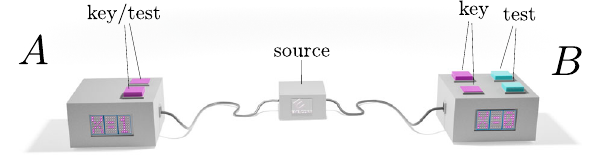
Fig. 1 Robust DIQKD. Alice and Bob use uncharacterised devices to perform measurements on a quantum state that is created by a source that is potentially controlled by an adversary (Eve). In the proposed protocol, Alice has two possible inputs (measurement settings, magenta buttons) which are used for key generation and for running the CHSH Bell test, and Bob has four possible inputs grouped into two sets (magenta/cyan buttons): the magenta buttons are used for key generation while the cyan buttons are used for running the CHSH Bell